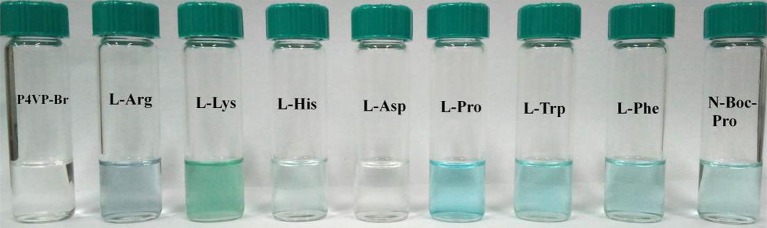
Photographic images of P4VP1-Br2 ethanol solutions containing different amino acids.